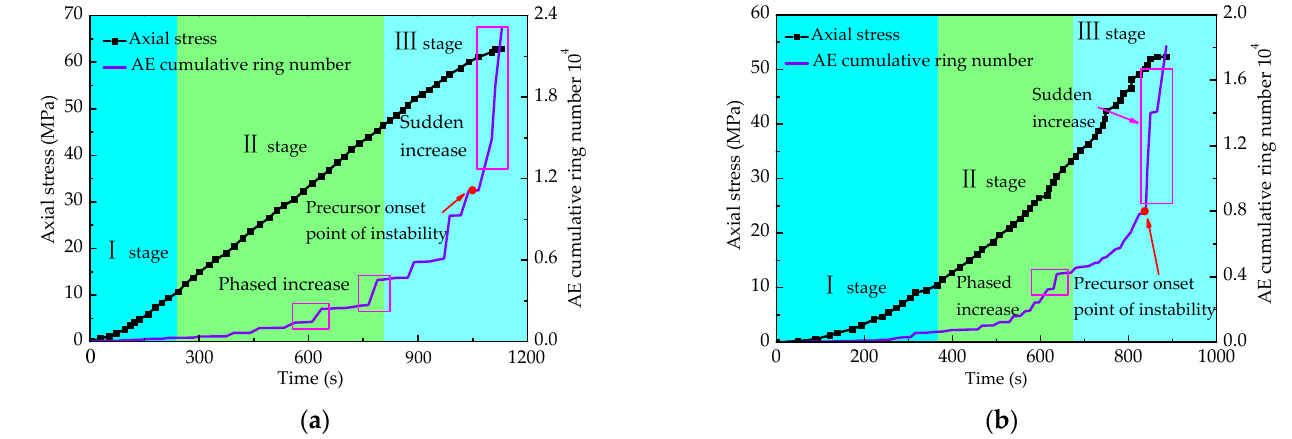
Figure 7. Evolution of AE cumulative ring number under vertical loading: ( a ) Gray samples; ( b ) Carbonaceous samples.